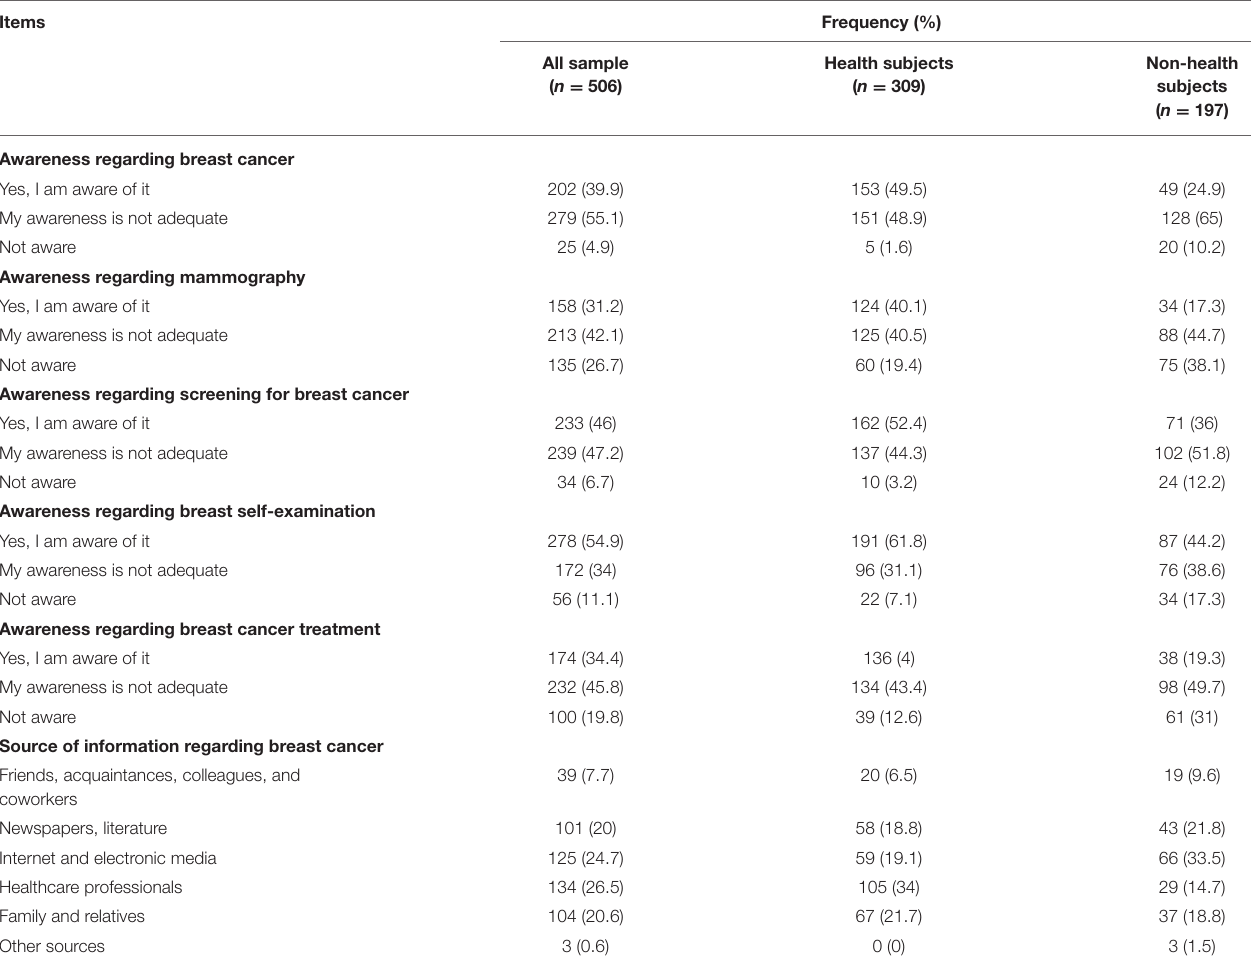
TABLE 2 | Awareness of breast cancer (BC) ( N =